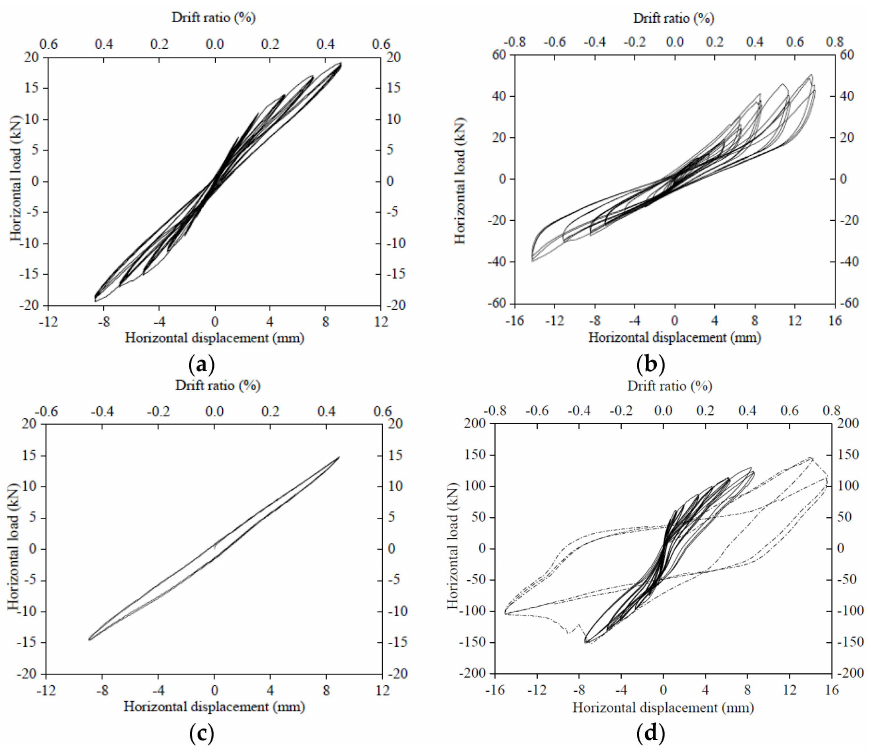
Figure 8. Hysteretic loop of the frame with different infilled forms: ( a ) Bare frame; ( b ) RC frame with DSP; ( c ) Double check test on the bare frame; ( d ) RC frame with